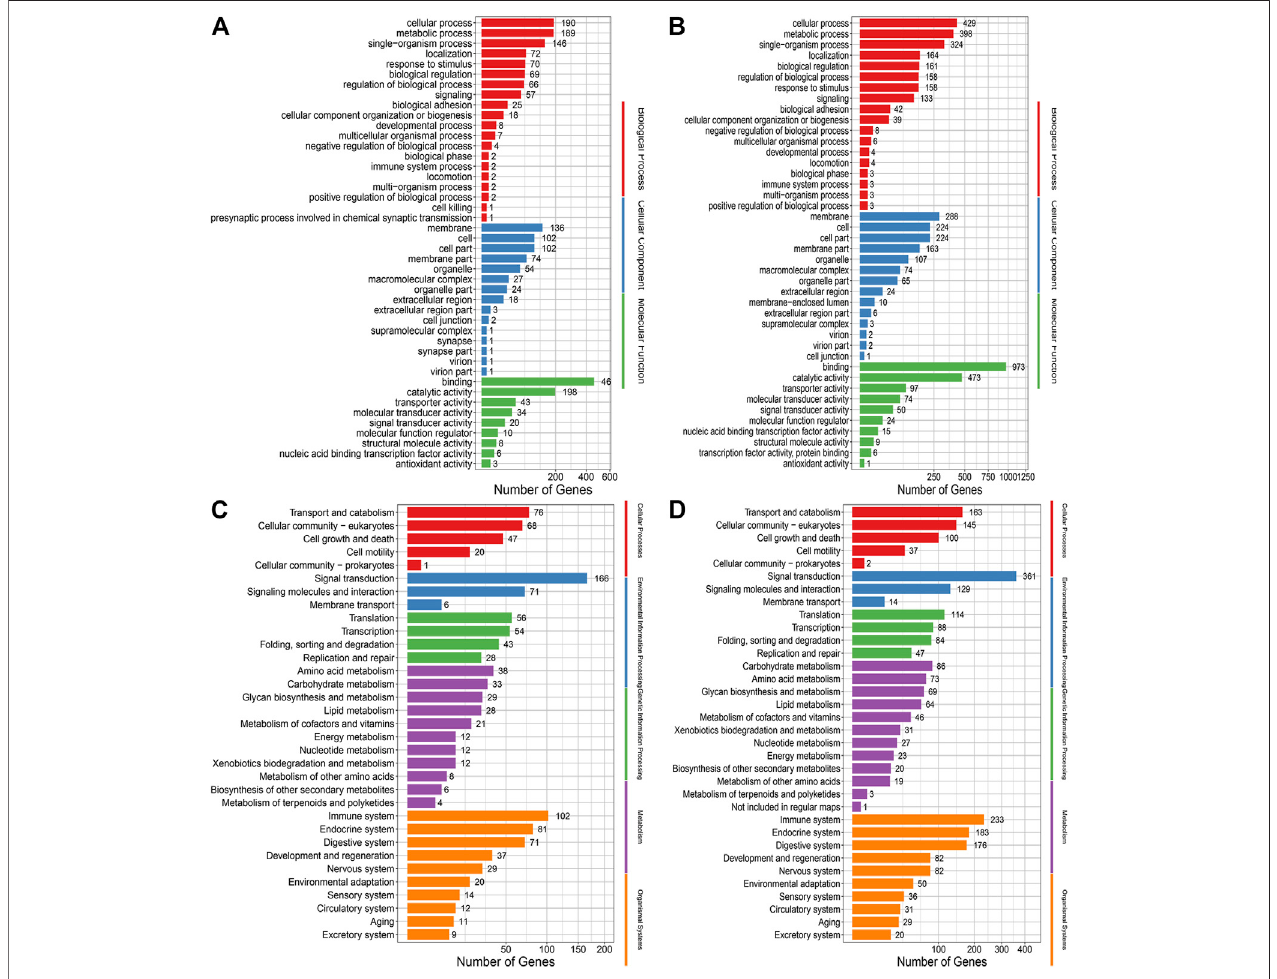
FIGURE6|(A) GOannotationanalysisofInDelsinthecontrolgroup. (B) GOannotationanalysisofIndelsinthetreatment group. (C) KEGGenrichmentanalysisof Indels in the control group. (D) KEGG enrichment analysis of Indels in the treatment group.